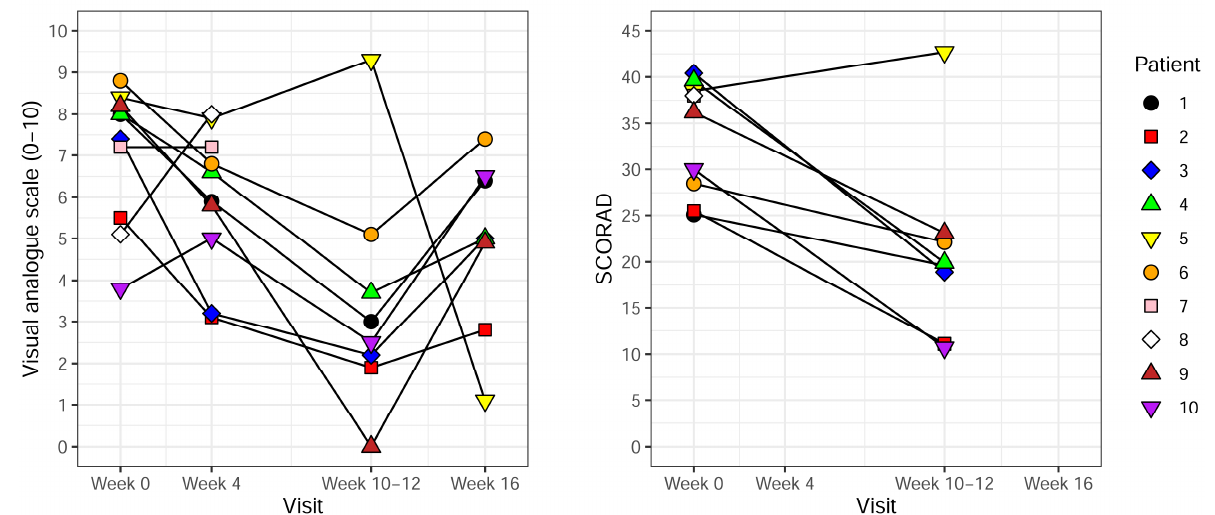
Figure 1. Visual analogue scale (VAS) and objective scoring atopic dermatitis (SCORAD) before, during, and after phototherapy with narrow band UVB (NB-UVB) in ten atopic dermatitis (AD) patients. VAS and SCORAD improved from visit 1 to 3 ( p = 0.017 and p = 0.016, respectively).